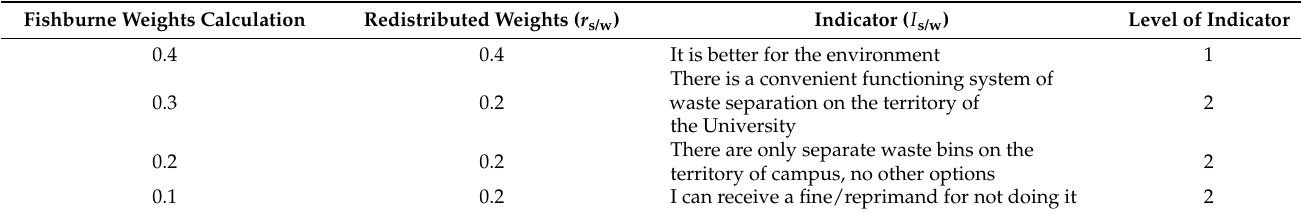
Table 15. Reasoning indicators for waste